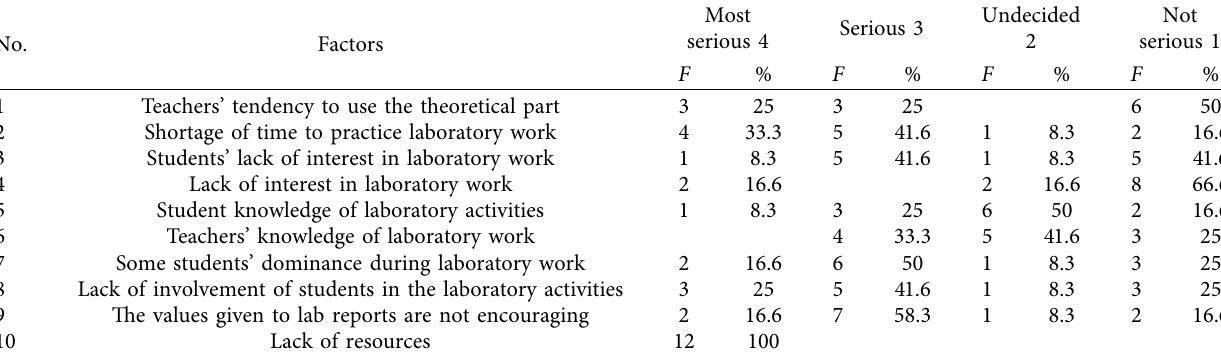
Table 9: Teachers’ response to possible factors that affect the practice of laboratory